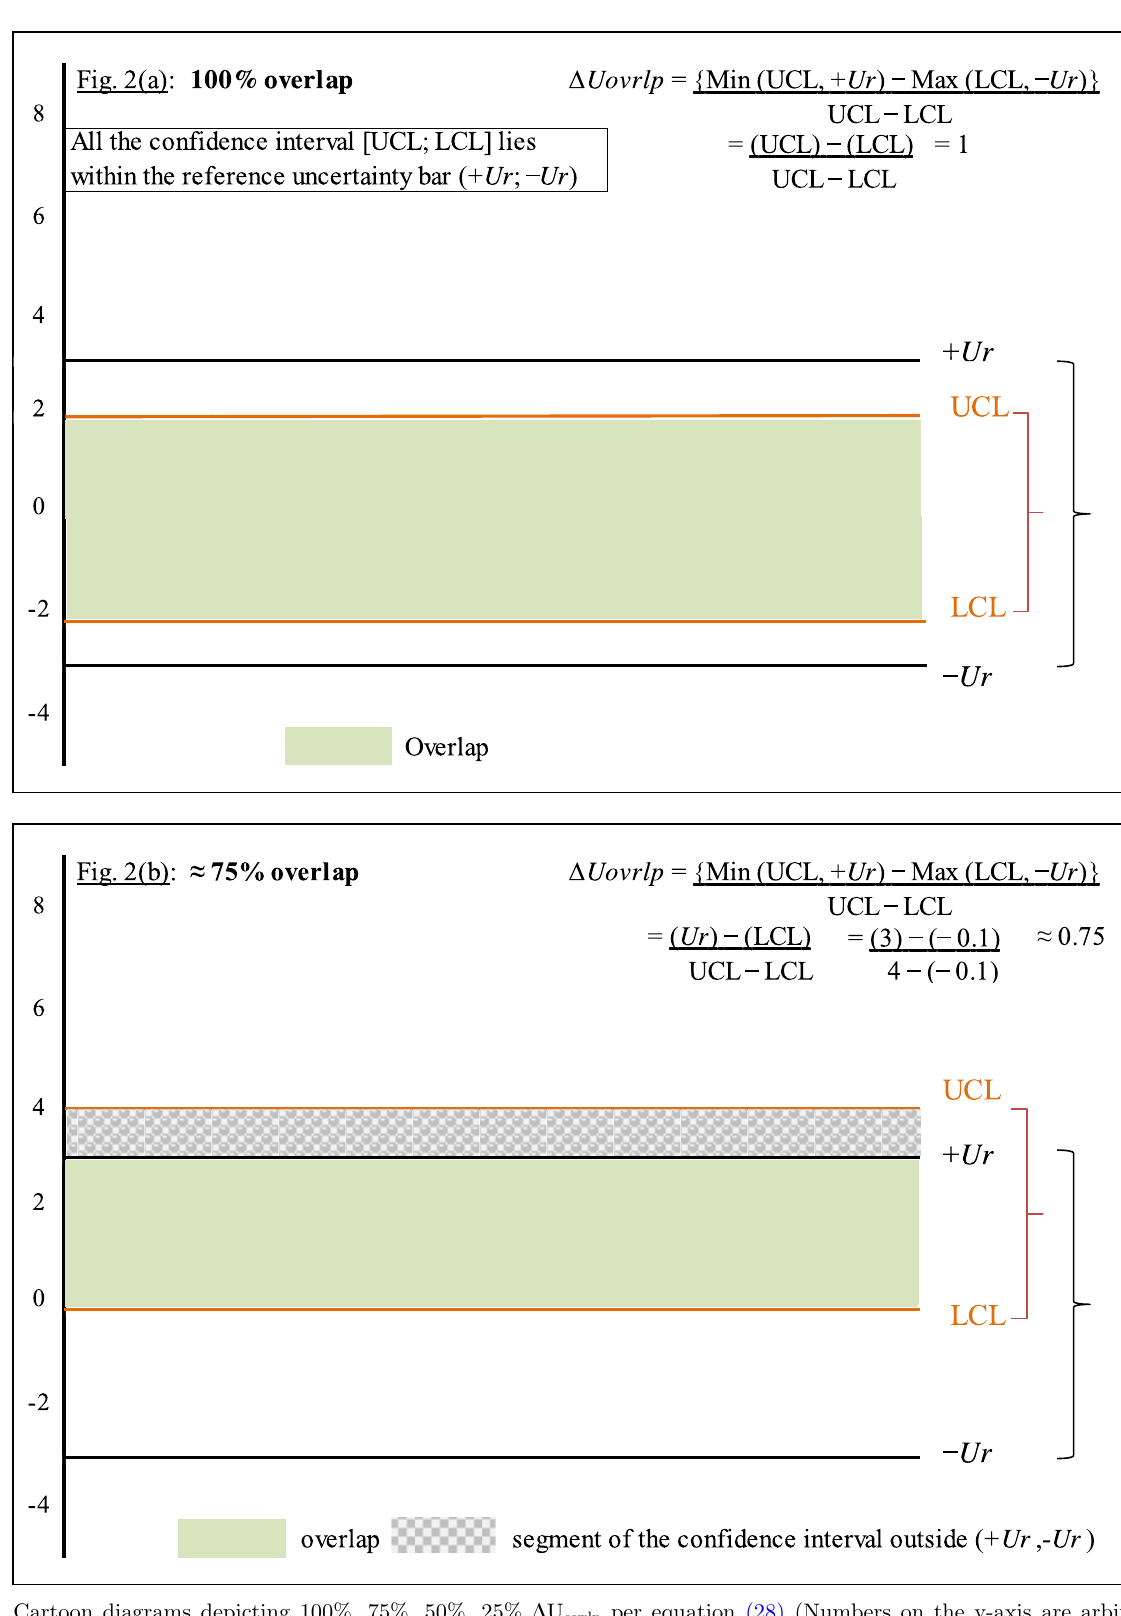
Fig. 2. Cartoon diagrams depicting 100%, 75%, 50%, 25% D U ovrlp per equation (28) (Numbers on the y-axis are arbitrary for illustration